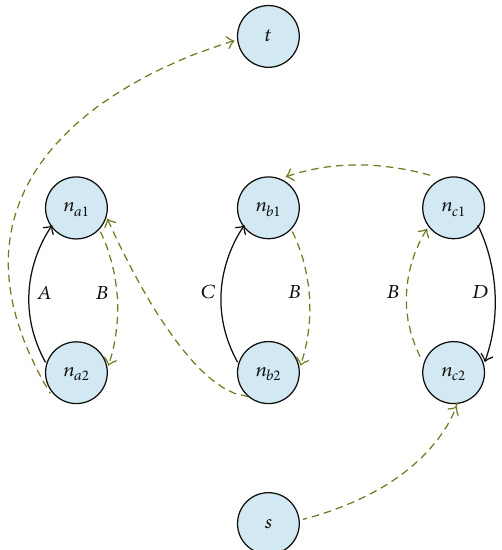
Figure 11: 𝐵 path, conflicting with the paths from the maximum independent set due to different selection of edge directions.